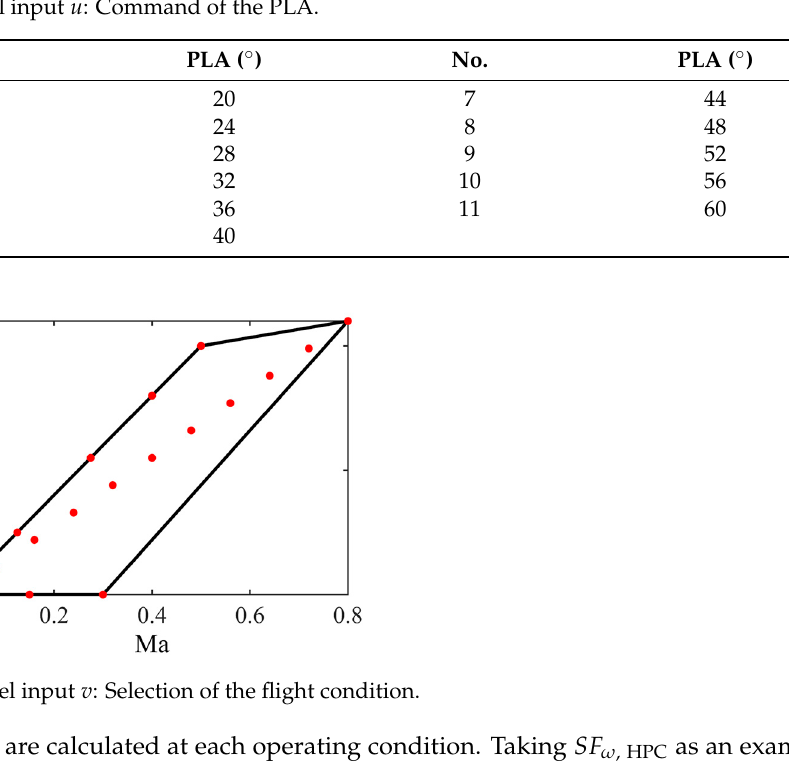
Figure 8. Regression analysis result of the mapping relationship: Case 2.